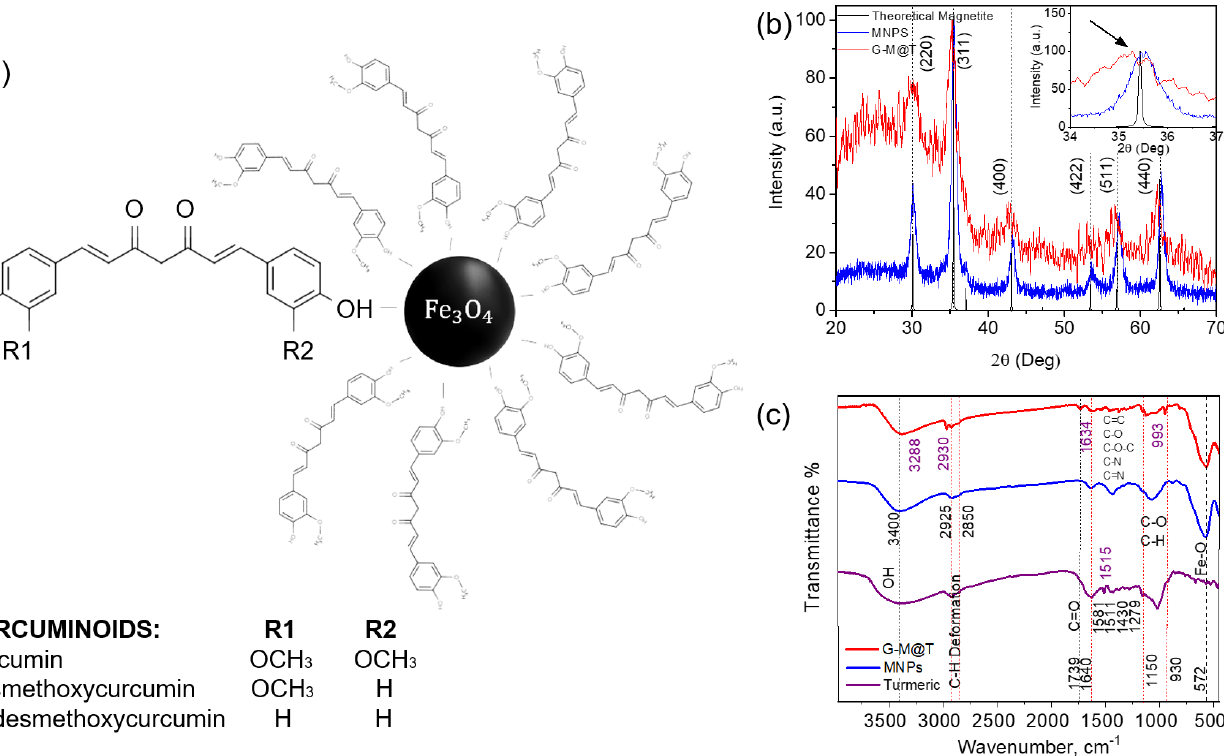
Figure 1. Configuration of Fe 3 O 4 synthesized covered by Curcuma longa L. extract C 21 H 20 O 6 ; ( a ) Curcumin bond –OH over MNPs. The polyphenolic coating was formed directly during the synthesis processing. Nature of bonding was covalent with Fe ions [66,67]. ( b ) XRD shows MNPs (blue line), G-M@T (red line), and the theoretical diffraction pattern of magnetite (black positions). The inset reveals a slight displacement of the peak corresponding to the (311) plane. The curve under the red line indicates the addition of C 21 H 20 O 6 over the MNPs surface. This had an amorphous response. ( c ) FT-IR spectra of the synthesized samples. It shows the presence of Fe–O and aromatic compounds on the nanoparticles’